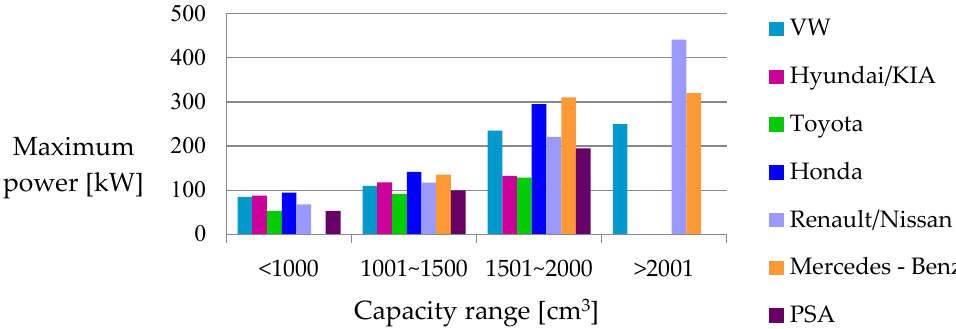
Figure 2. Maximum power in each engine capacity compartment; European and Asian car brands. Source: Developed own.